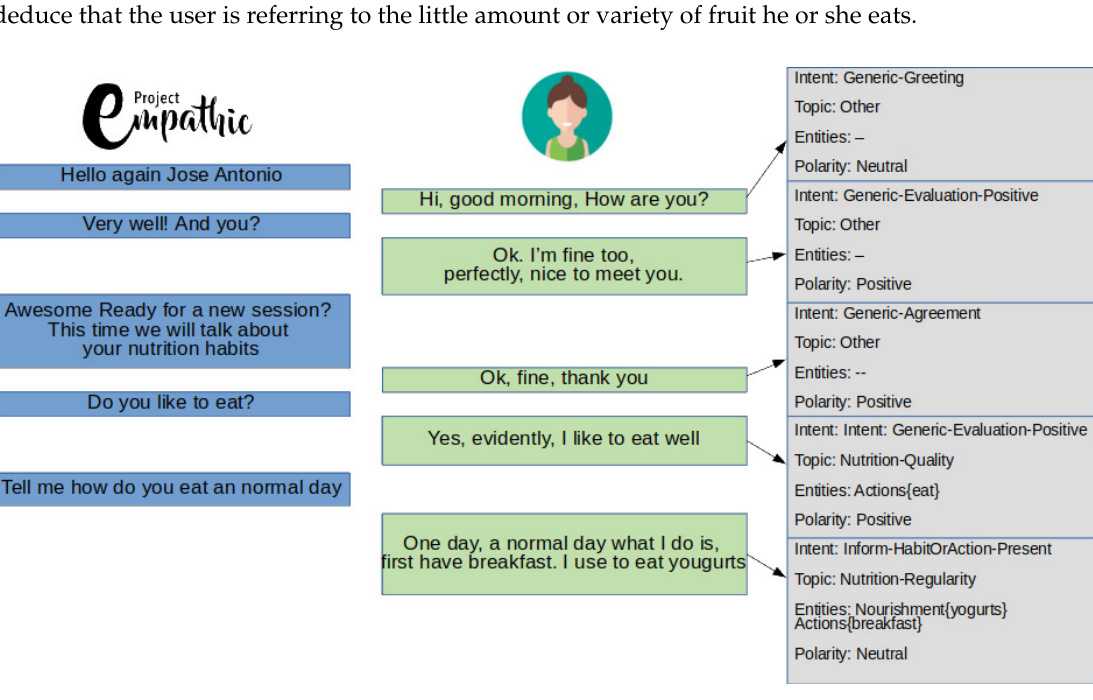
Figure 2. English conversation